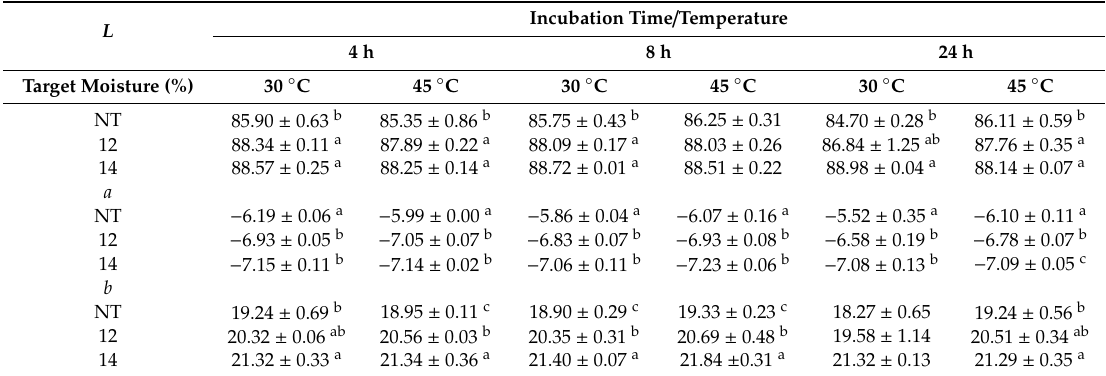
Table 2. Color of intermediate wheatgrass flour subjected to di ff erent tempering